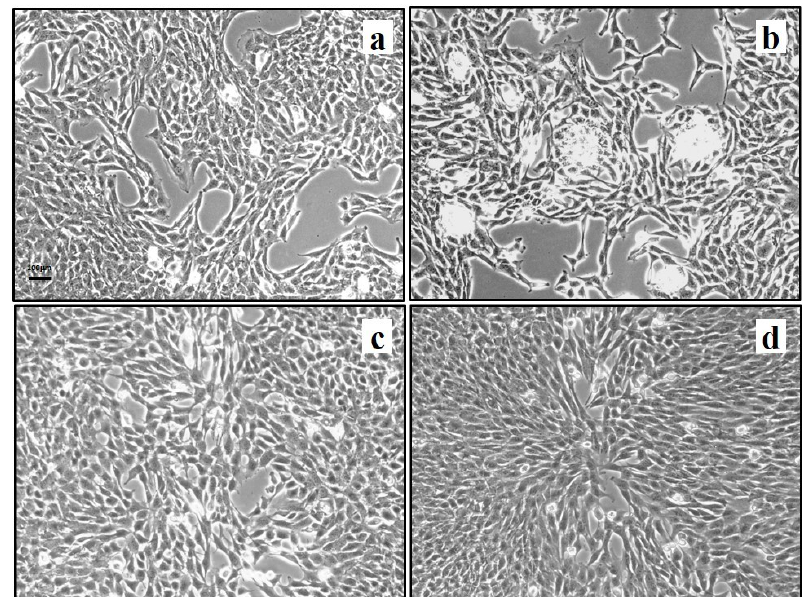
Figure 7. Effect of PRP treatment on NIH-3T3 cells exposed to modeled μg : cell morphology. Cells were exposed to modeled μg or maintained at 1 × g (controls) for 72 h in presence/absence exposed to modeled µ g or maintained at 1 × g (controls) for 72 h in presence / absence of PRP (1:1000). of PRP (1:1000). 1 × g ( a ); μg ( b ); 1 × g + PRP ( c ); μg + PRP ( d ). Bar = 100 μm. 1 × g ( a ); µ g ( b ); 1 × g + PRP ( c ); µ g + PRP ( d ). Bar = 100 µ m.